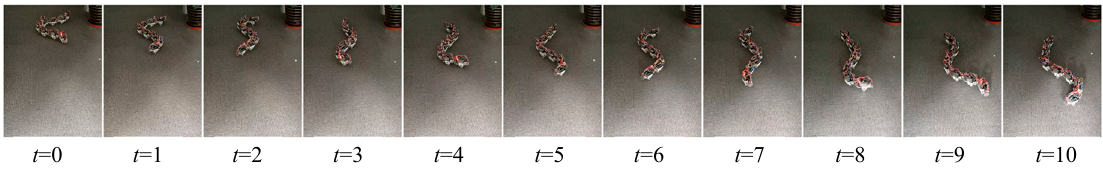
, (cid:1854) = 2.4 ∙ (cid:2024), (cid:1855) = (cid:3095) . ( b ) (cid:2871) (cid:2872) , (cid:1854) = 2.4 ∙ (cid:2024), (cid:1855) = (cid:3398) (cid:3095) . (cid:2871) (cid:2874)